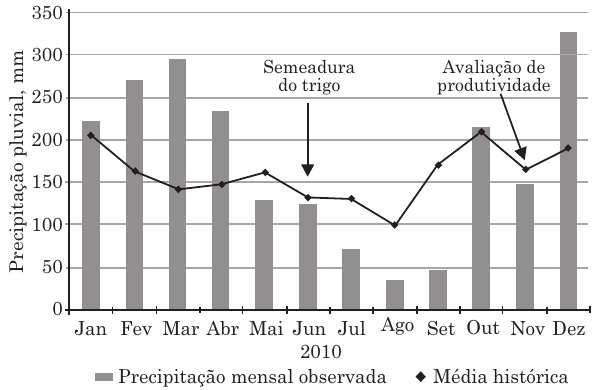
Figura 1. Precipitação pluvial mensal média histórica (1976-2010), na estação meteorológica do IAPAR, em Guarapuava, PR, e mensal observada (pluviômetro), na propriedade em Reserva do Iguaçu, PR, em 2010. Fonte: IAPAR